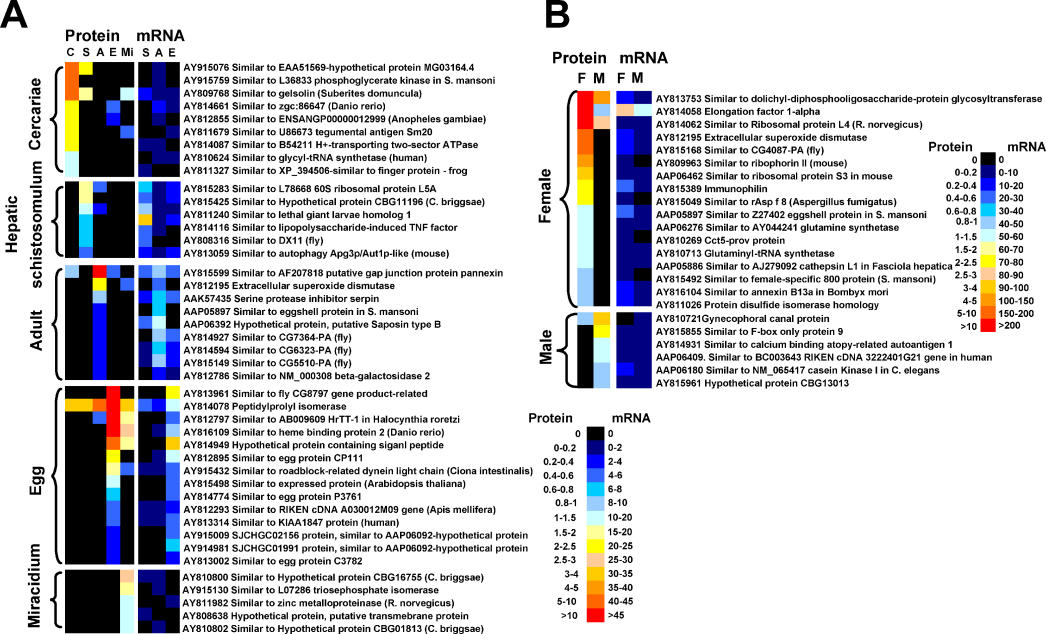
Correlation between Transcriptomic and Proteomic Data of Selected Schistosome Proteins among Developmental Stages and Sexes(A) Some developmental stage-enriched proteins were consistent with the transcriptomic data indicated. C, cercariae; S, hepatic schistosomula; A, adults; E, eggs; and Mi, miracidia. Those significant proteins with more than a 3-fold difference were consistent with the differential display (p < 0.05) based on EST copy numbers throughout hepatic schistosomula, adults and eggs, or between female and male worms. For cercariae and miracidia, we only showed some proteins with more than 3-fold differences throughout the life cycle based on quantitative proteomics since both stages are devoid of ESTs. However, the selected proteins have low EST copy numbers in other developmental stages.(B) Gender-enriched proteins are also shown as colored boxes: F, females; M, males. Protein abundance and EST frequencies are shown in different colored boxes, as the icons indicate where the EST frequency represents the ratio of EST copy numbers of a given gene to the total number of all ESTs derived from the corresponding cDNA library and then multiplied by 10,000. The full datasets of stage-enriched and gender-enriched proteins with consistency between transcriptomic and proteomic data were given in Figure S4.